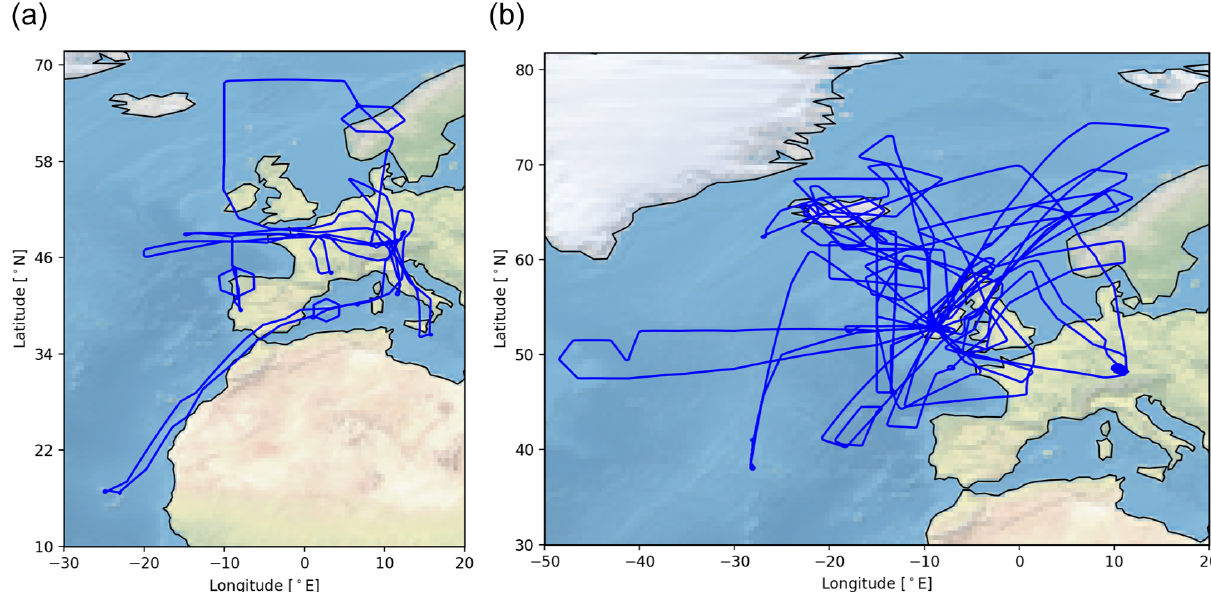
Figure 1. Flight tracks of HALO during the (a) TACTS campaign (late August and September 2012) and (b) WISE campaign (September– October 2017). The basis of the TACTS campaign was mainly Oberpfaffenhofen (near Munich in Germany), while the basis of the WISE campaign was Shannon (Ireland).